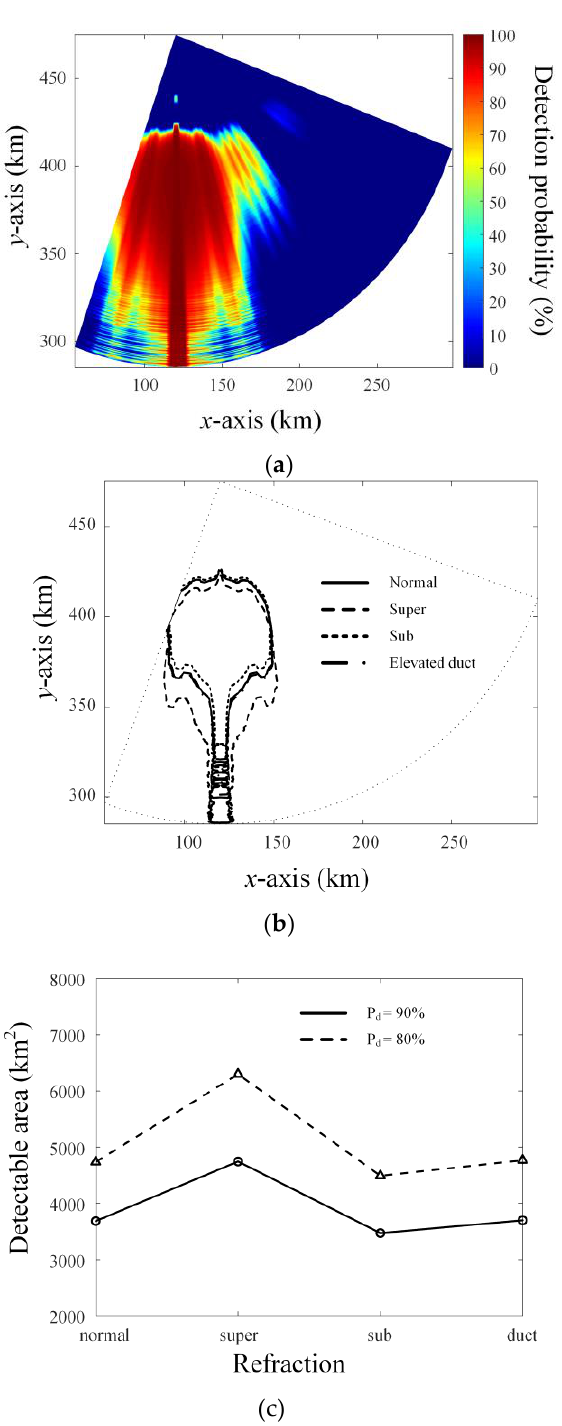
Figure 8. Simulation results of the TDP along the range and the azimuth angle for the first scenario: ( a ) TDP in a super-refraction; ( b ) contour plots of TDP in an anomalous atmospheric environment; ( c ) detectable area results for TDPs over 80% and 90%.